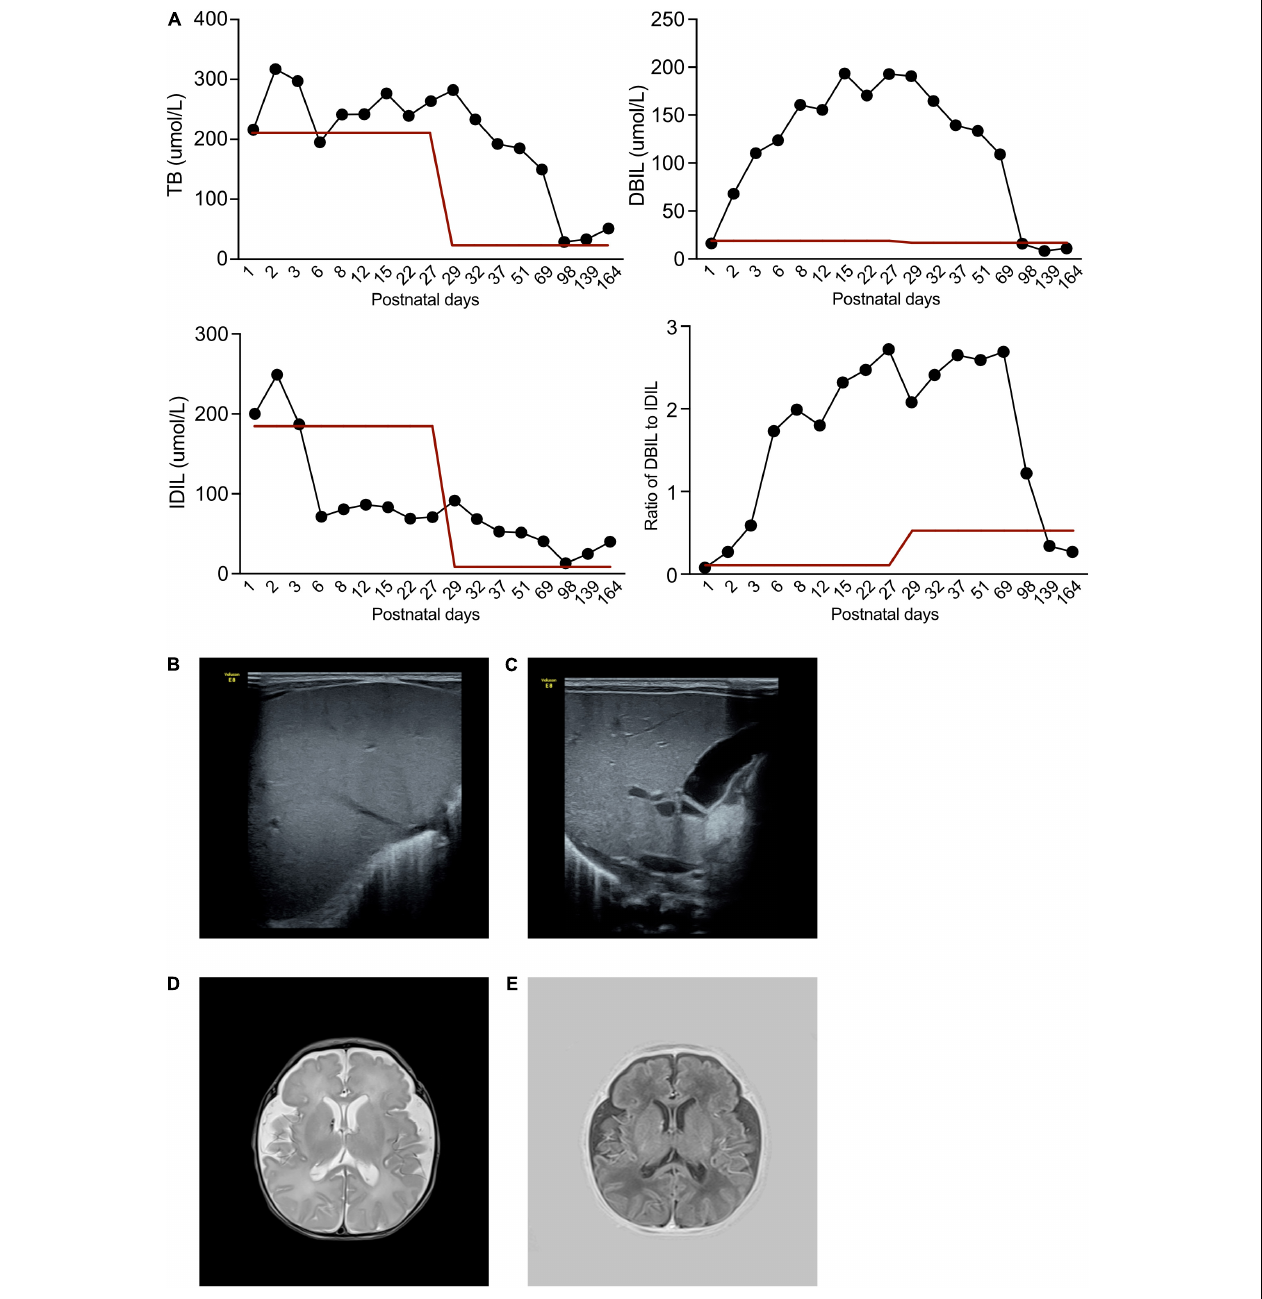
FIGURE 1 | Clinical and radiology manifestation in the current proband. (A) The patient exhibited abnormal bilirubin in plasma, while the total bilirubin remained high during his illness. At the beginning, DBIL elevated rapidly to a high level, while IDIL remained normal. However, after 3 months follow-up, DBIL dropped to normal level, and IDIL increased. (B) Hepatic ultrasound demonstrated a normal density of liver. (C) Gallbladder demonstrated a normal morphology. (D,E) The cerebral MRI identified hematoma near right cerebral ventricle.